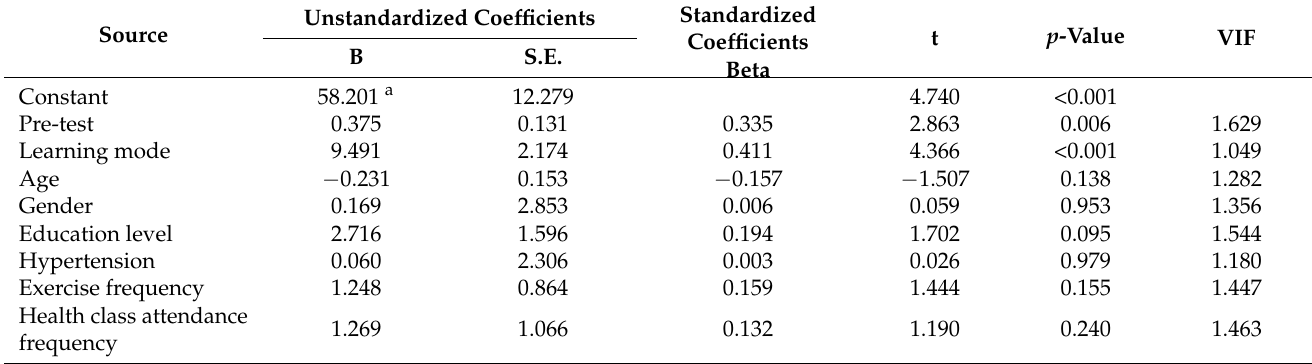
Table 4. The result of regression analysis on health knowledge. Dependent variable: post-test on health knowledge.